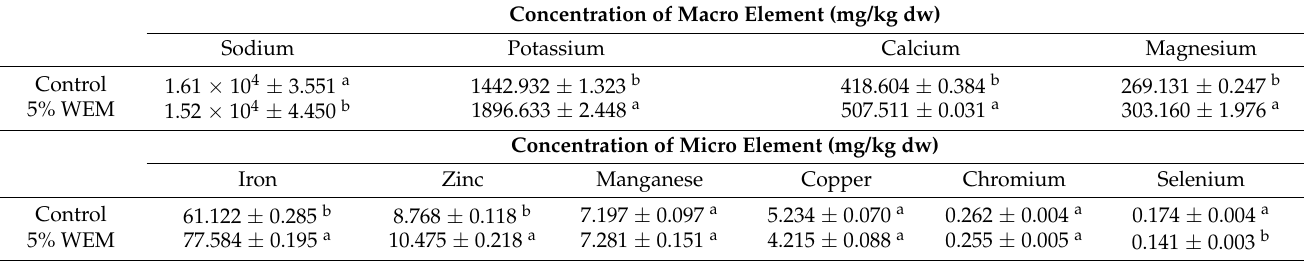
Table 4. The mineral element content of noodles incorporated with WEM and without WEM